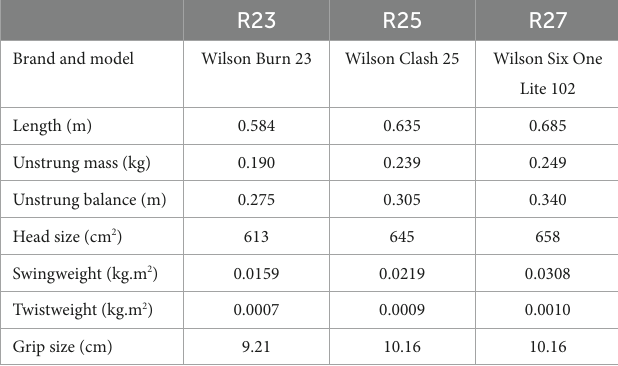
TABLE 1 Characteristics of the three racquets used in the